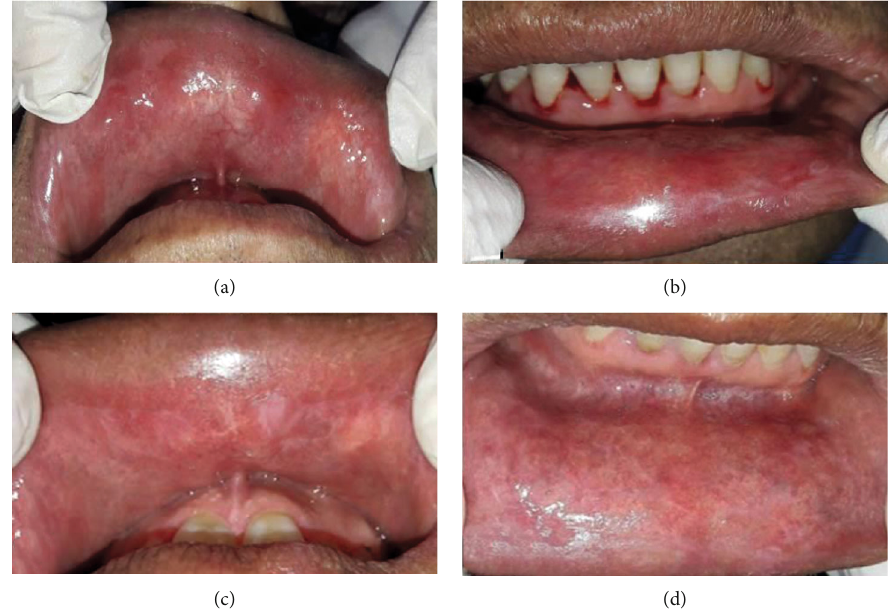
Figure 2: Intraoral view: inner side of the labial mucosa in di ff erent stages of the treatment. (a, b) Widespread redness with erosive lesions. (c, d) Disappearance of the erosions with the presence of slight reticular pattern.